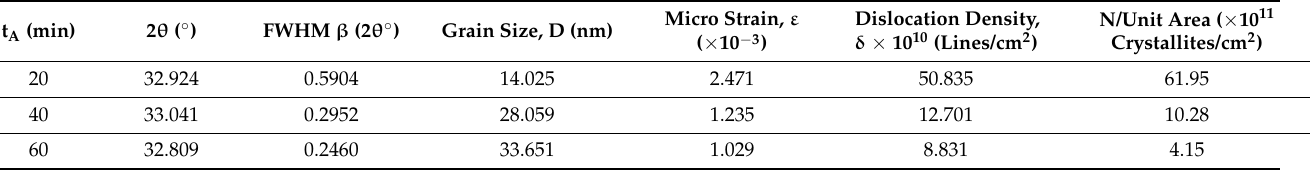
Table 3. Calculated values of the structural parameters of CdO thin films at different annealing